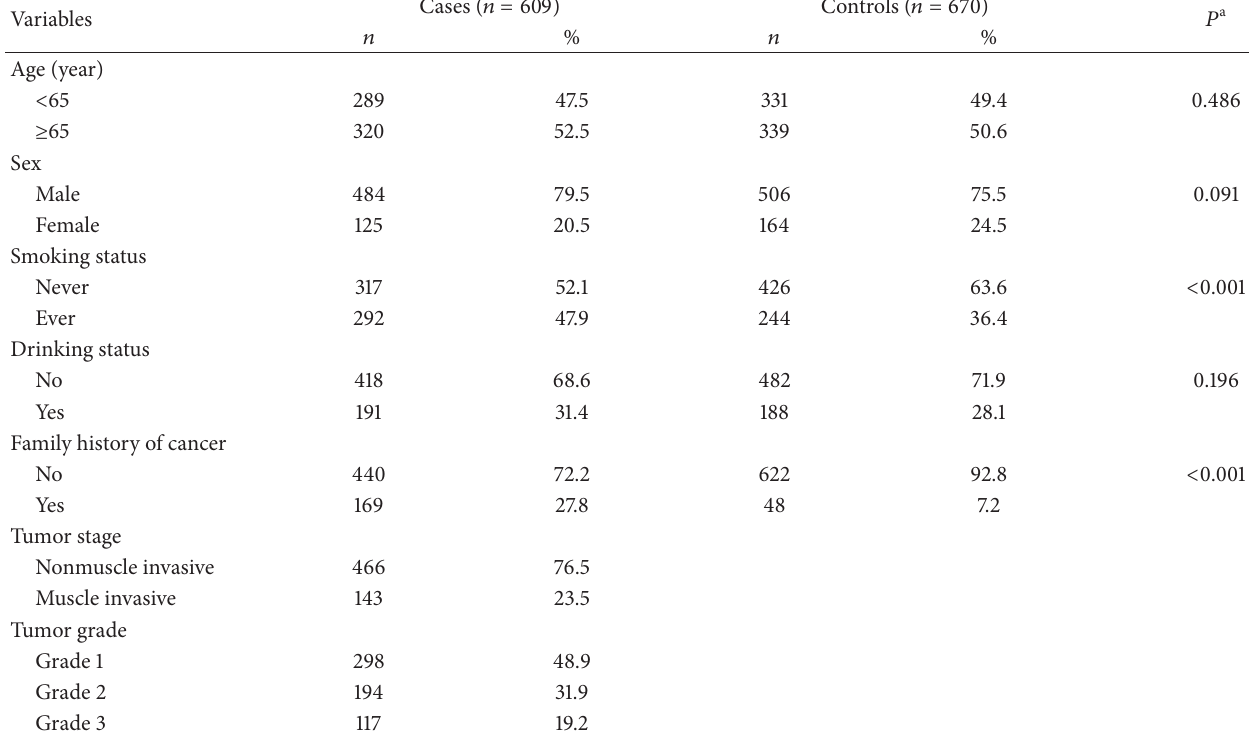
Table 1: Frequency distribution of selected variables of the bladder cancer cases and